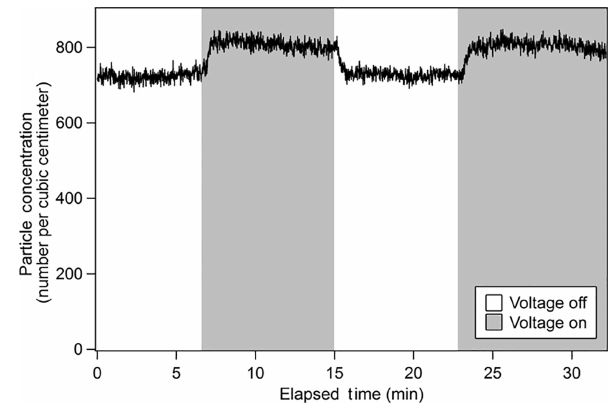
Figure 5. SMPS particle concentration trace with and without ap- plied voltages. 200nm, 30kV applied voltage.